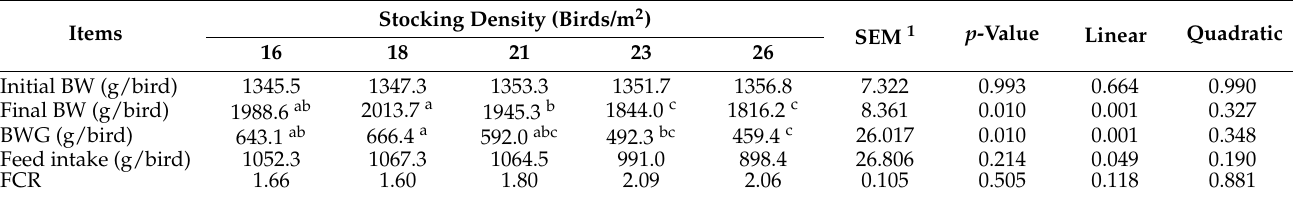
Table 1. Effect of stocking density on performance of broiler chickens under high temperature during days